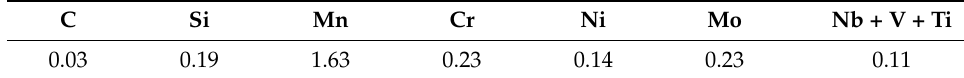
Table 1. Chemical compositions in wt.% of X80M steel.